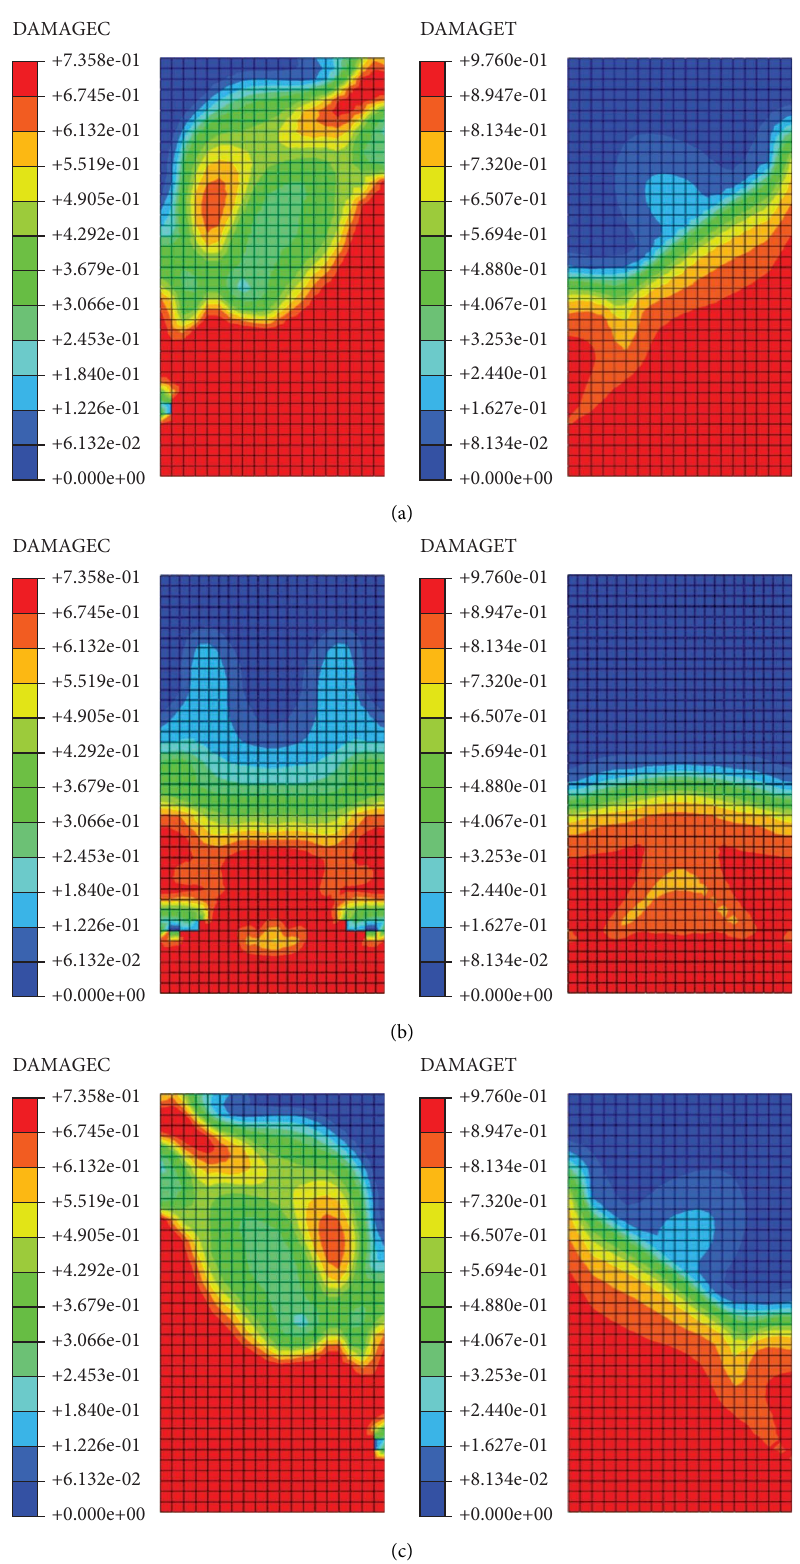
Figure 25: URC-Y compression and tensile damage distribution clouds of the member. (a) Wall limb 1 compression and tensile damage distribution clouds. (b) Web compression and tensile damage distribution clouds. (c) Wall limb 2 compression and tensile damage distribution